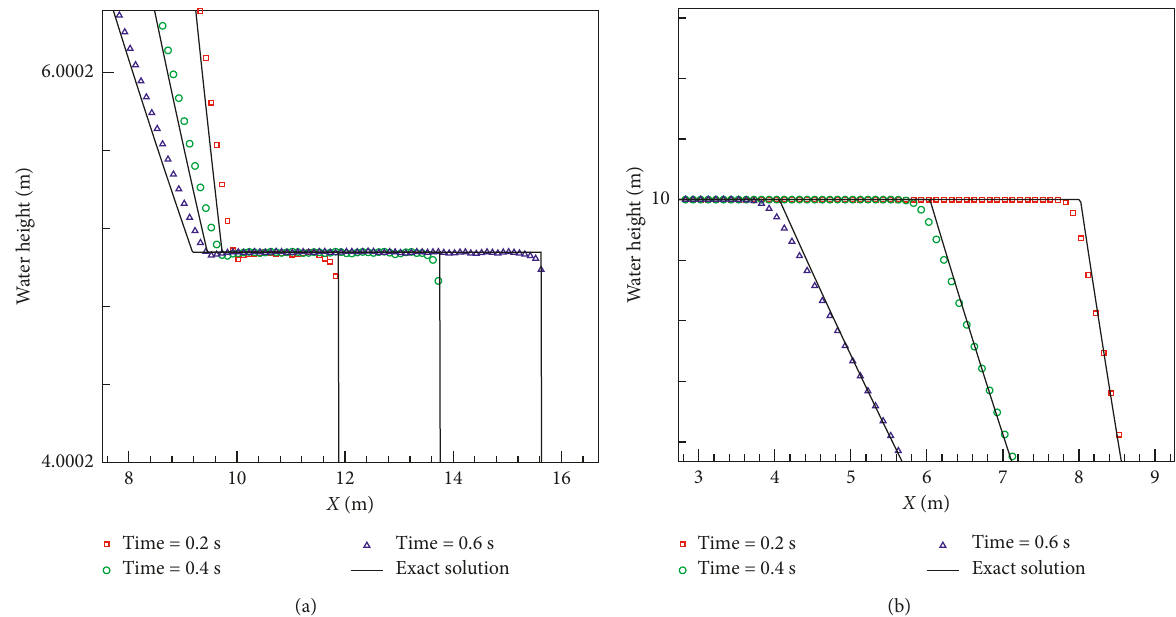
Figure 1: Numerical and exact solutions of a dam break on a wet bed, at different times, using a grid of 800 points: (a) free surface elevation profiles; (b) profiles of water discharge per unit